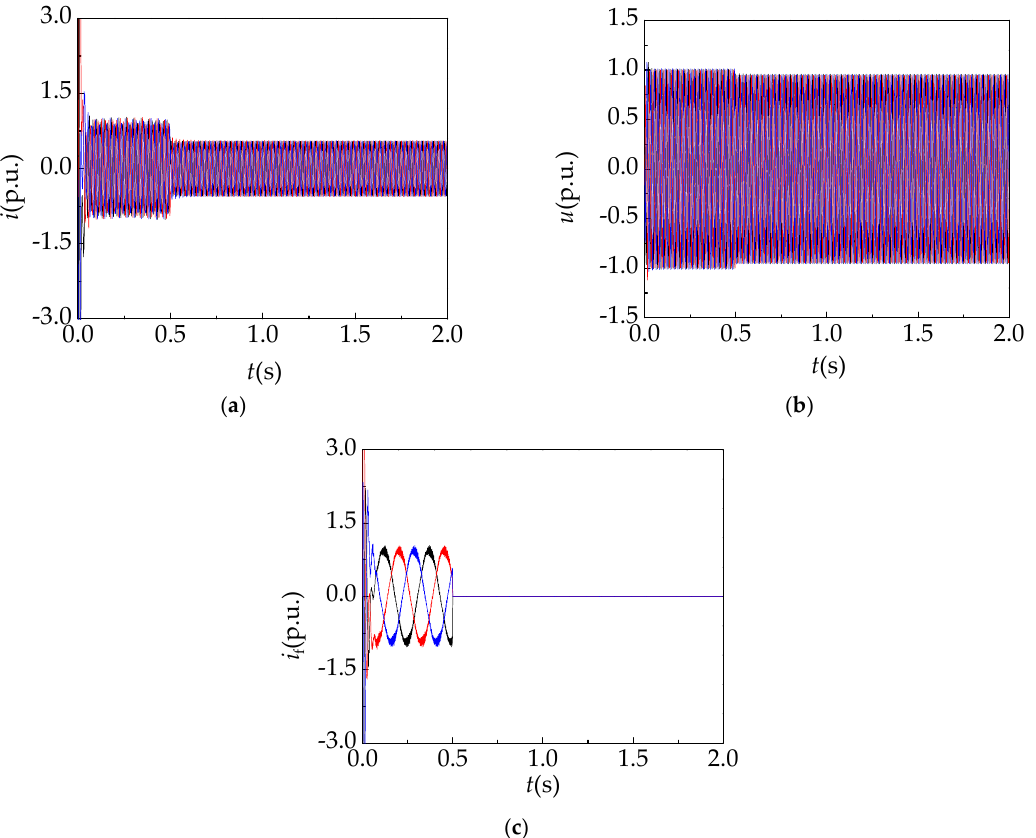
Figure 11. The waveforms of electrical quantities after the three phase open-circuit loss of excitation in the subsynchronous operation state, when s is 0.08: ( a ) Stator current; ( b ) stator induced voltage; ( c ) rotor current.